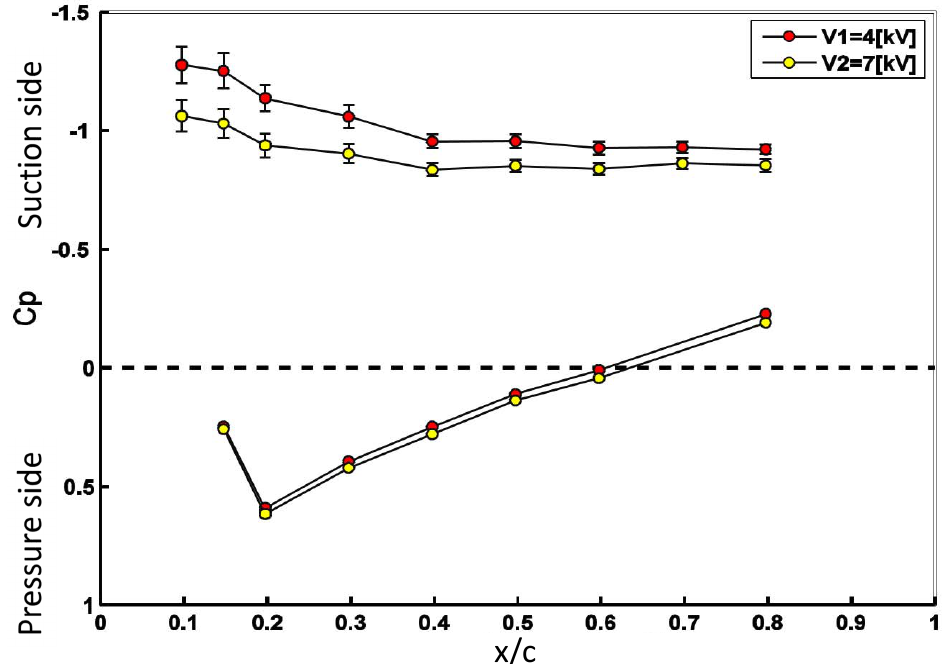
Figure 23. C p distribution comparing applied voltages at Re = 200,000 and α = 16 ◦ , and actuation frequency f =